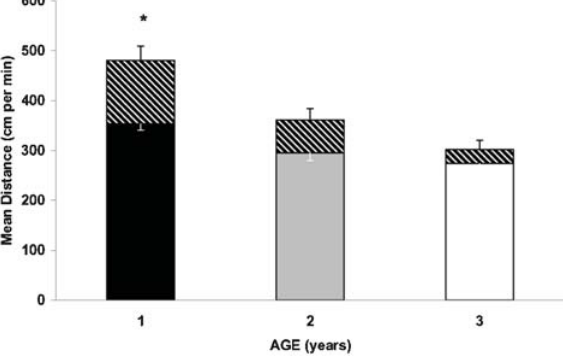
Figure 4. Baseline locomotor activity level is significantly reduced in middle-aged (2 years old) and old (3 year old) fish, compared to young (1 year old) zebrafish. Y axis: mean distance traversed. Solid color of each bar – slow motion; diagonal part –fast motion. * p , 0.05 for comparisons between young and middle-aged, and p , 0.001 between young and old zebrafish. No significant difference between two older groups.